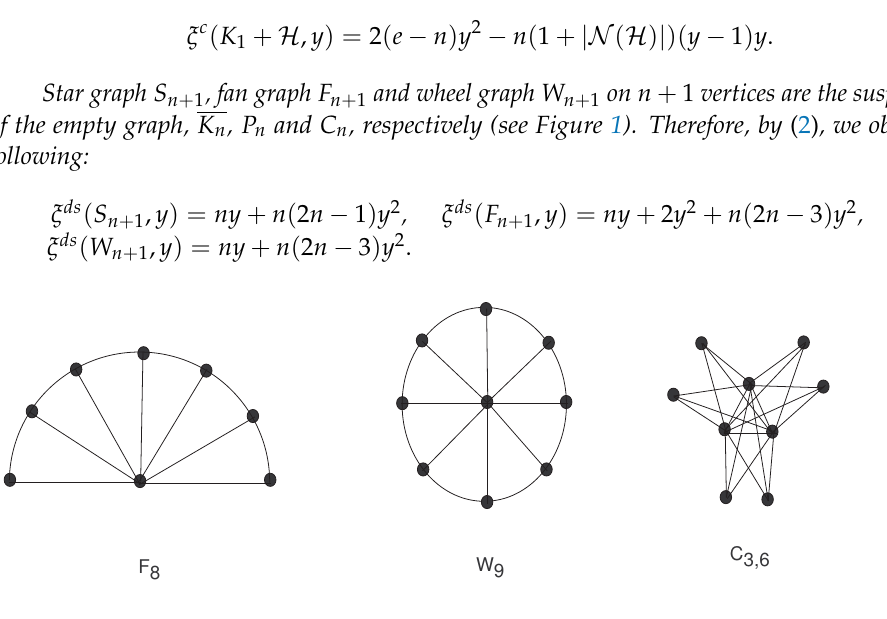
Figure 1. The fan graph F 8 , wheel graphs W 9 and cone graph C 3,6